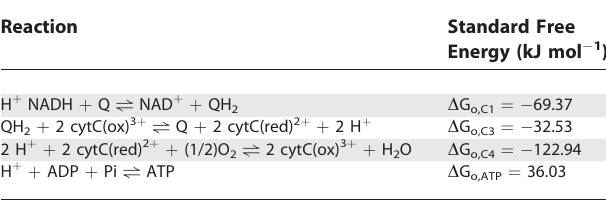
Table 2. Standard Free Energies of Respiratory Chain Reactions